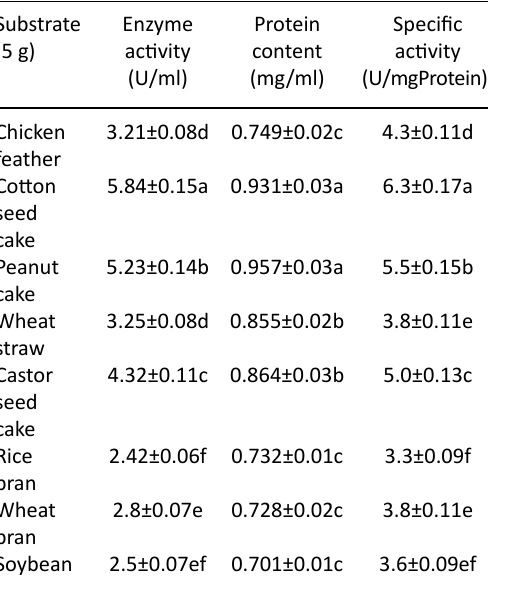
Table 3. Effect of different metal ions on activity of the purified SSF laccase produced by S. mutabilis